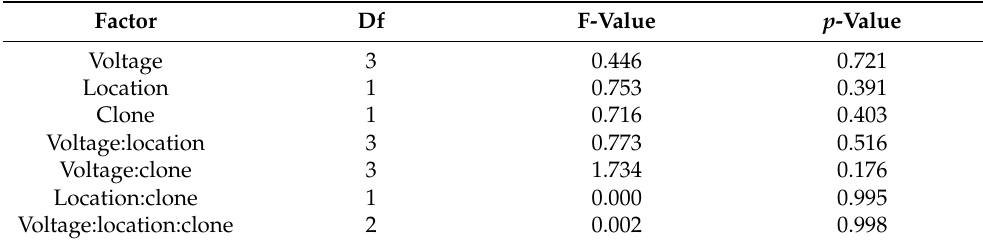
Table 5. Rootwave experiment. Effects of the parameters voltage, location, clone, and their interac- tions on vitality of mother tubers from C. esculentus plants electrocuted with the Rootwave device in 2021.